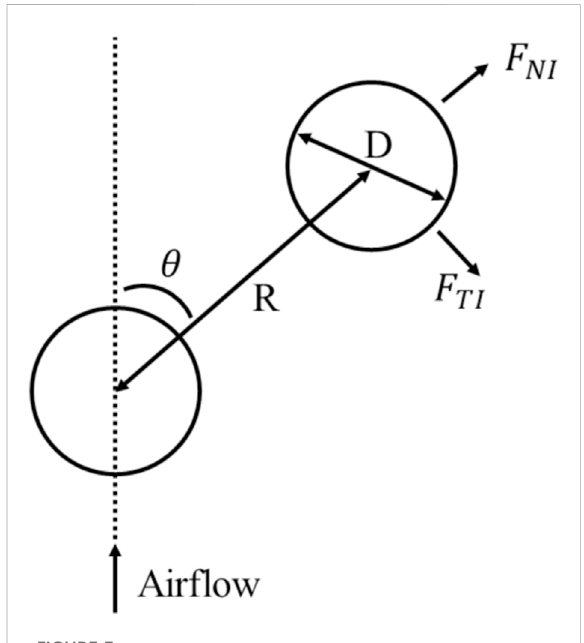
FIGURE 3 The interaction model of the collective Bernoulli-ball system in simulation. F NI is the normal interaction force, and F TI is the tangential interaction force between two balls. θ is the angle of attack of two balls, D is the diameter of the ball and R is the distance between two balls. The interaction forces depend on θ and R / D .